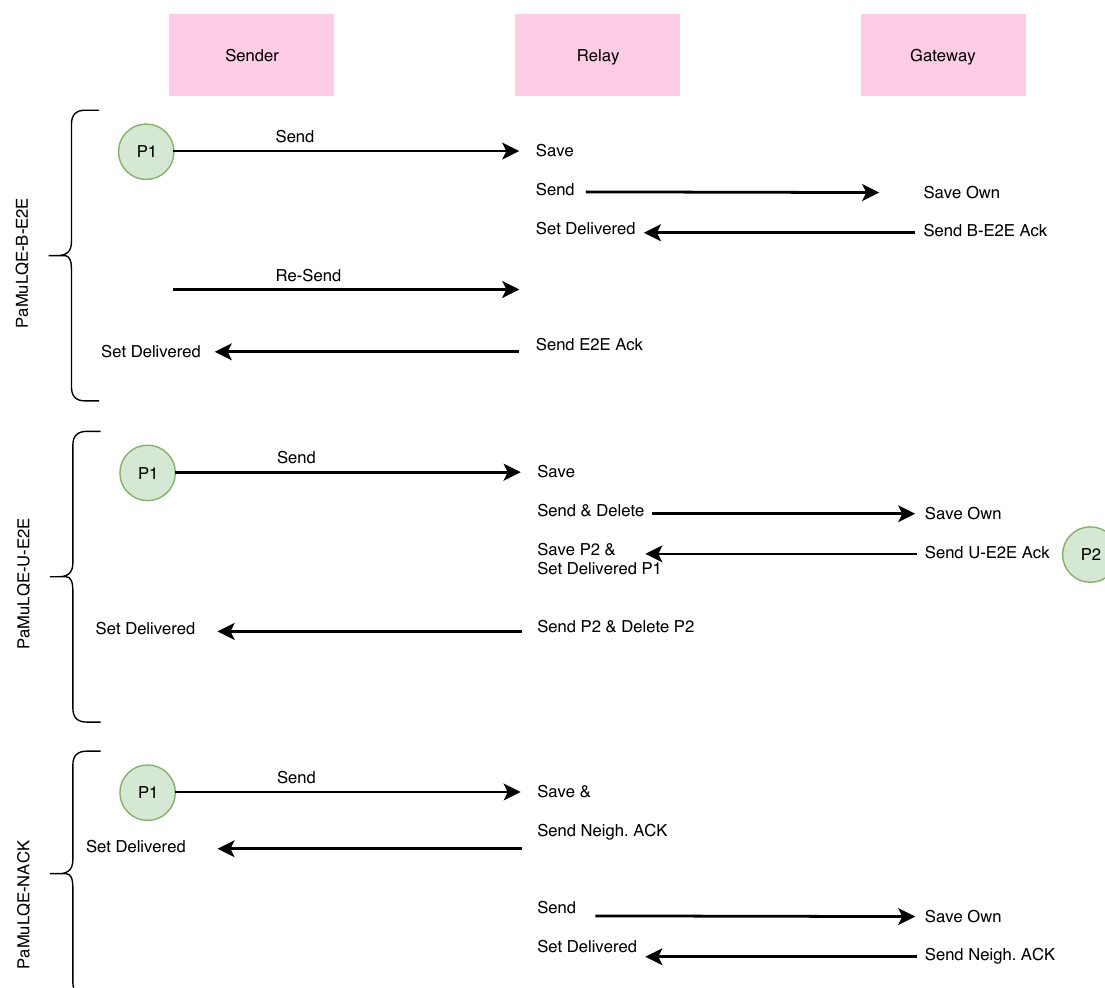
Figure 6. Routing logic for the three variants of the link quality-based routing strategy. Algorithm 1 represents the rationale behind the link quality-based proposed forwarding